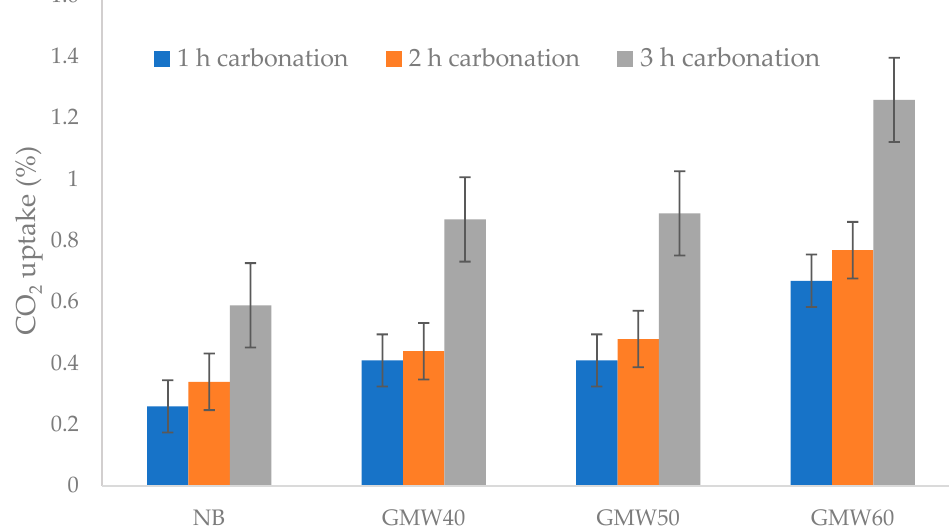
Figure 7. CO 2 uptake of mine waste bricks at different carbonation times.